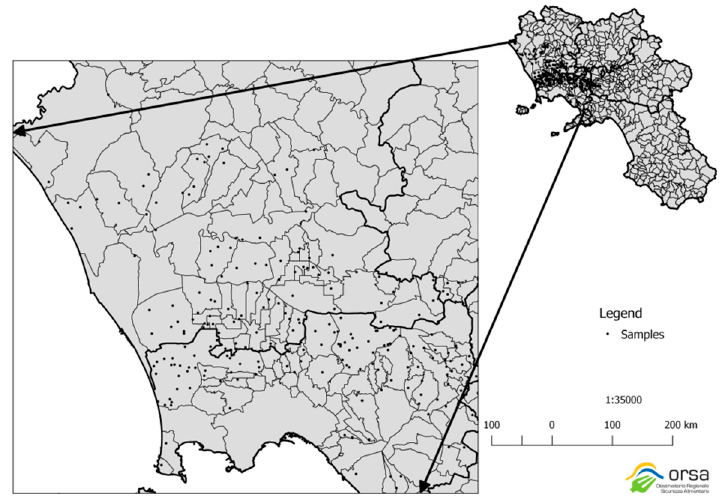
Figure 1. Map showing the zones of sampling sites of vegetables and fruit samples from the “Land of Fires.”